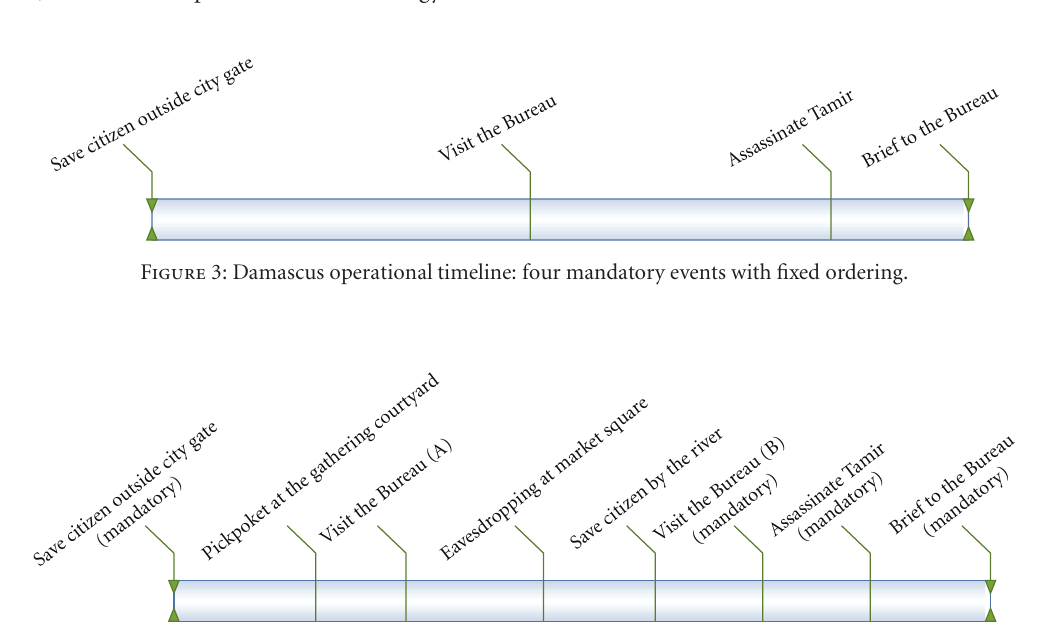
Figure 4: Damascus operational timeline: Sequence